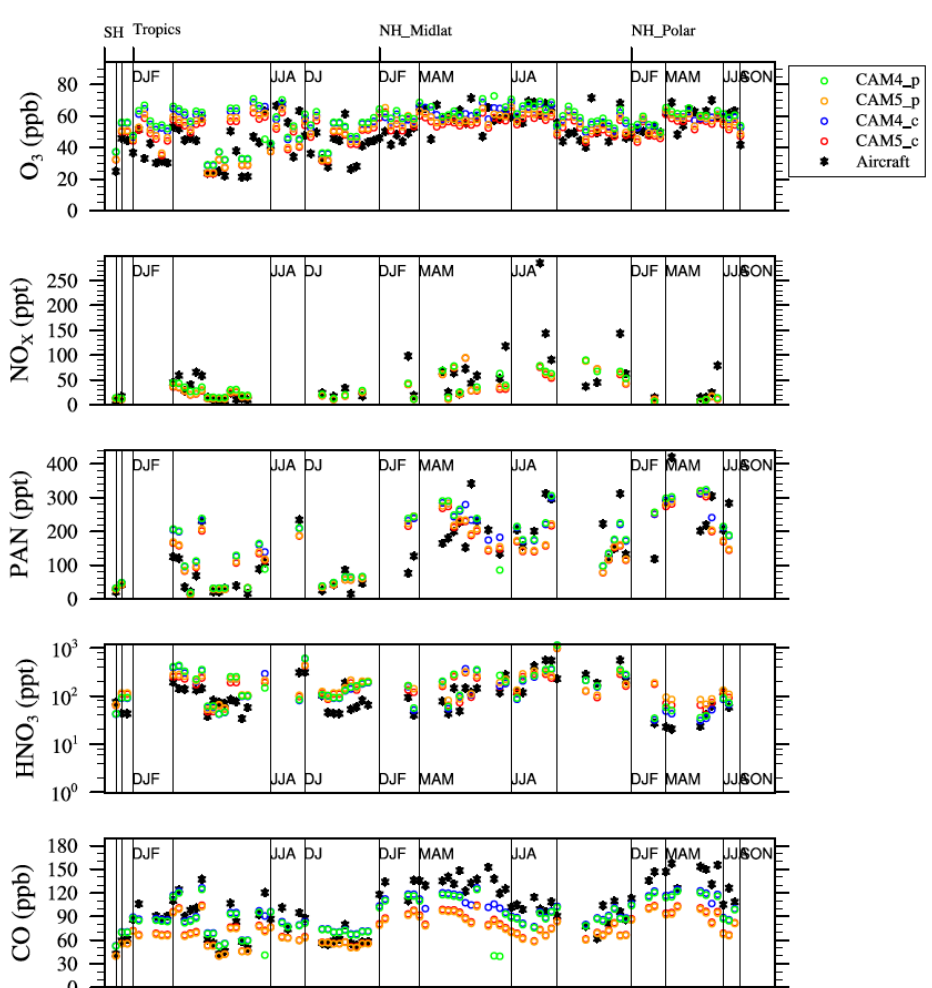
Figure 2. Comparison between aircraft observations over different regions and seasons and different model simulation, averaged between 2 and 7km, for ozone, NO x , PAN, HNO 3 , and CO, based on an updated version of the aircraft climatology by Emmons et al. (2000), as described in detail in Tilmes et al. (2014). *_p and *_c refer to the perturbed and control simulations,